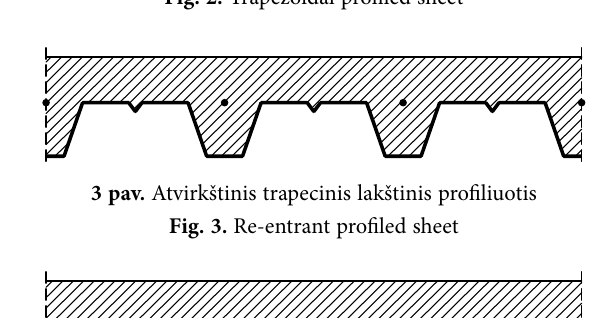
Fig. 2. Trapezoidal profiled sheet